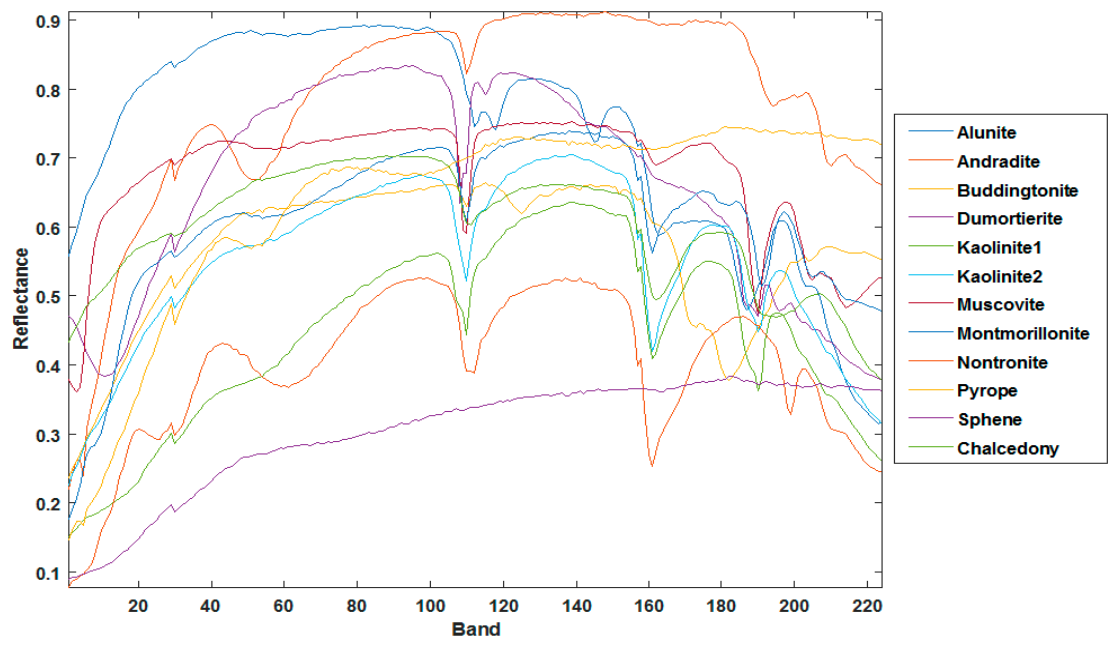
Figure 7. Comparison of abundance maps of the fourth end member estimated by different methods. 跨页